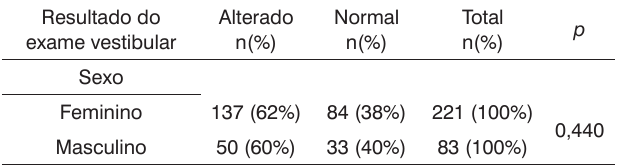
Tabela 2. Associação entre resultado do exame vestibular e sexo da amostra (Teste Qui-Quadrado).